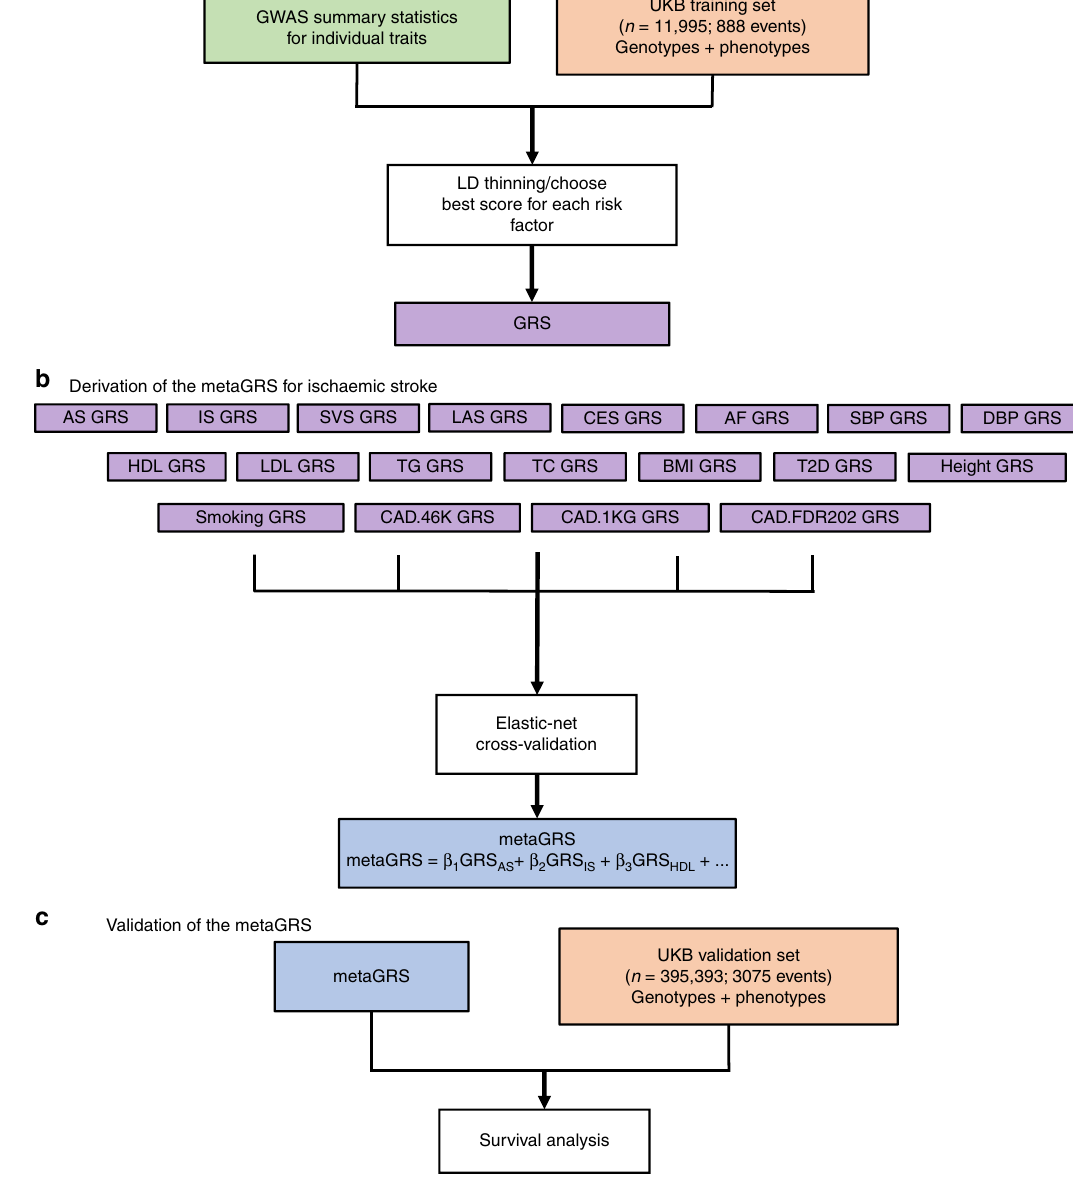
Fig. 1 Study design. a Individual GRSs were derived in the UK Biobank training set ( n = 11,995) using GWAS summary statistics for individual traits. b The metaGRS for ischaemic stroke was then derived by integrating individual GRSs using elastic-net cross-validation. c Validation of the metaGRS for ischaemic stroke was performed in the UK Biobank validation set ( n = 395,393). UKB UK Biobank, GWAS genome-wide association study, GRS genomic risk